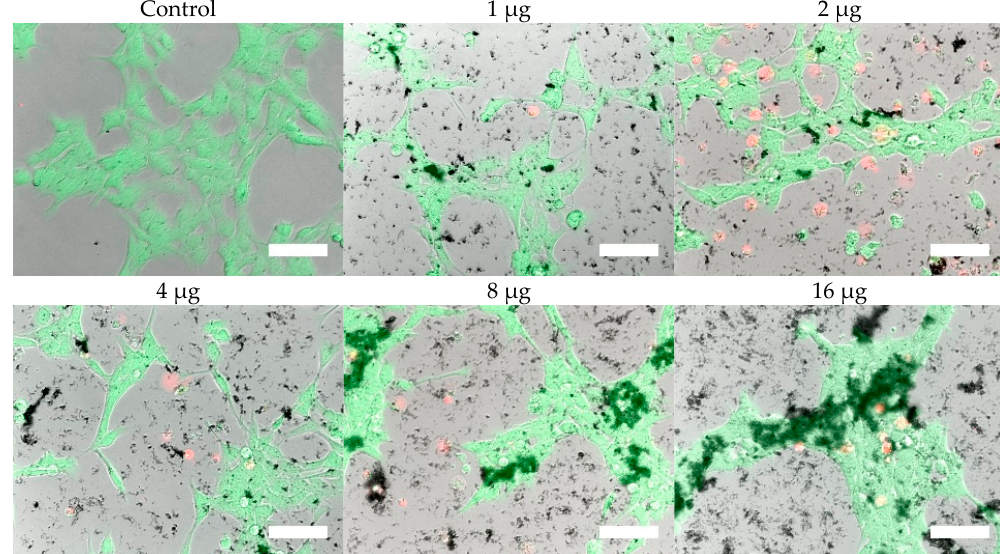
Figure 8. LIVE/DEAD assay results of RVM cells treated with hydrophilic iron oxide nanoparticles after 24 h. Calcein (green) indicates live cells while ethidium homodimer-1 (red) indicates dead cells. Scale bar = 50 µm.